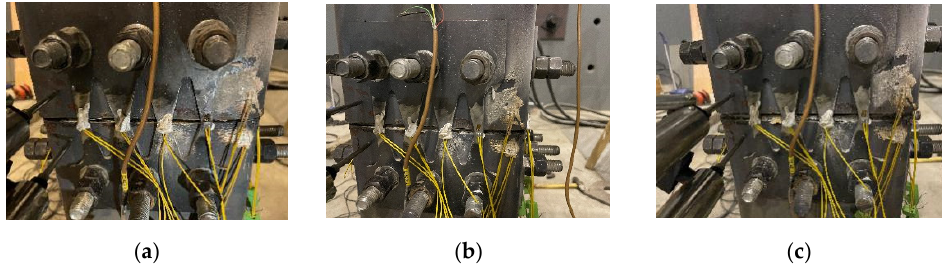
Figure 13. Opening at the joints, ( a ) Offset rate 2.2%, ( b ) Offset rate 4.2%, ( c ) Offset rate 6.2%.